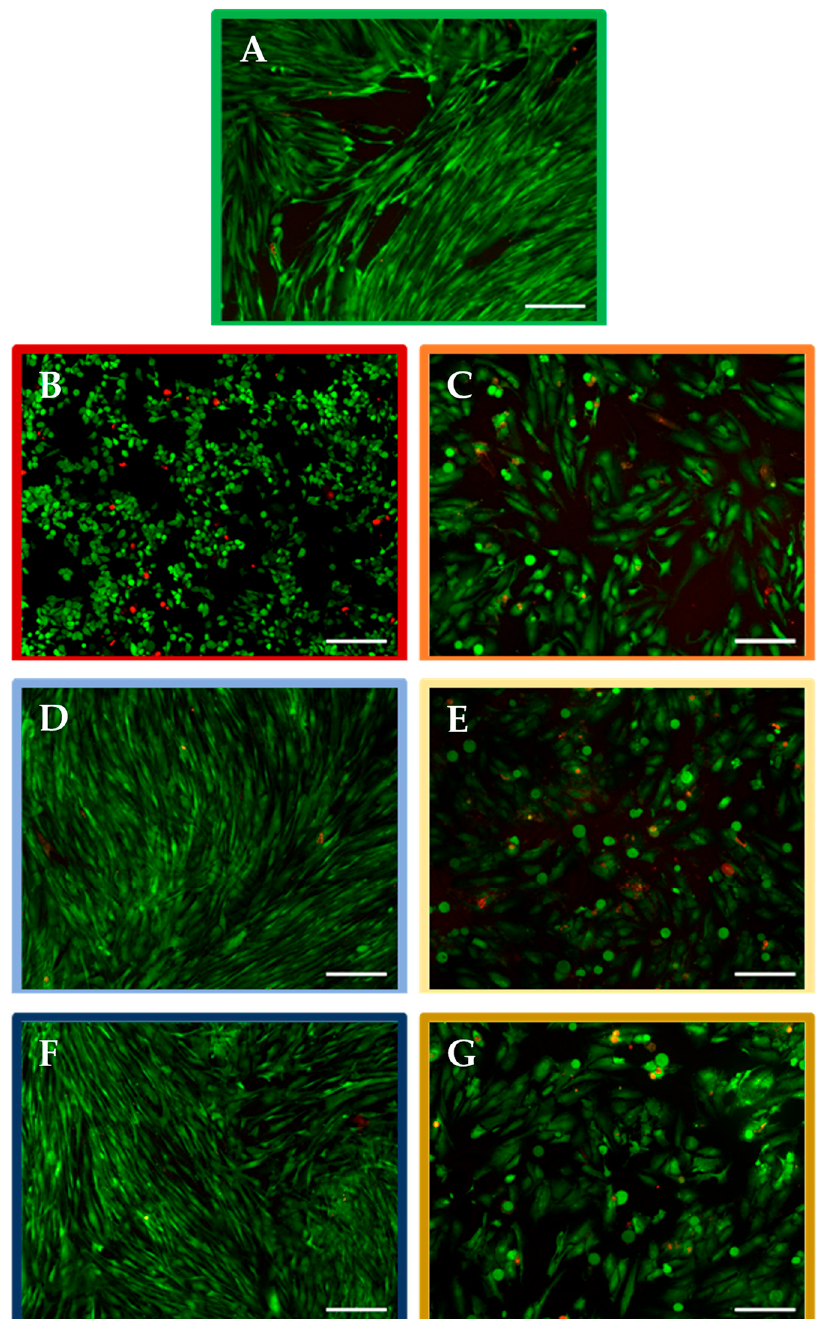
Figure 2. Live/dead images of human BJ fibroblasts after 48 h of exposure to nurP28 peptide alone and in combination with DTX. ( A ) Untreated cells (vehicle control); ( B ) 10 µM DTX; ( C ) 1 µM DTX; ( D ) 3 ng/mL nurP28; ( E ) 3 ng/mL nurP28 + 1 µM DTX; ( F ) 300 ng/mL nurP28; and ( G ) 300 ng/mL nurP28 + 1 µM DTX. Viable cells appear green and those with compromised metabolic activity appear orange/red. Magnification: 10×. Scale bar: 100 µM.